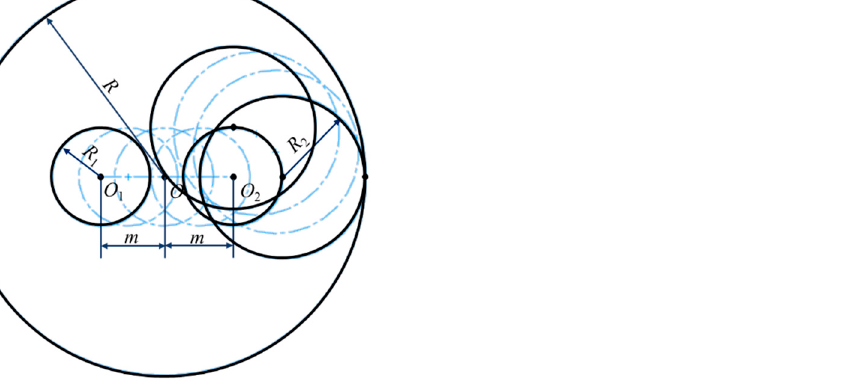
Figure 9. The comprehensive deviation envelope circle of the fastening bolt head of the new integrated disc cutter system.